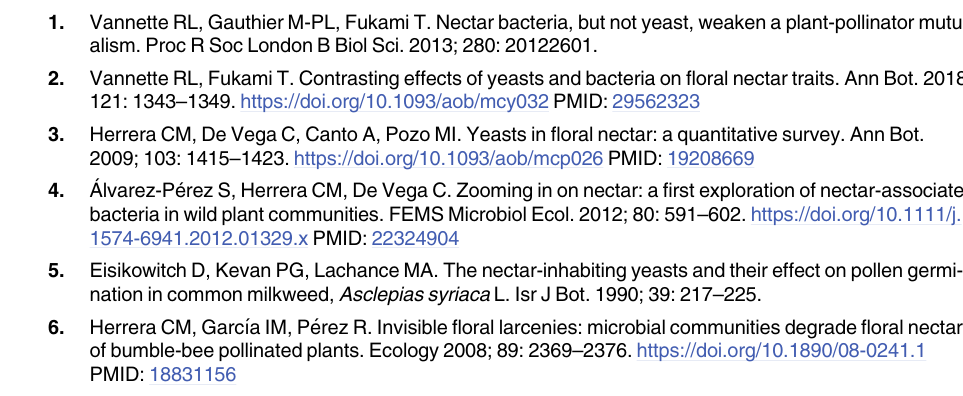
S1 Table. Data regarding microbial